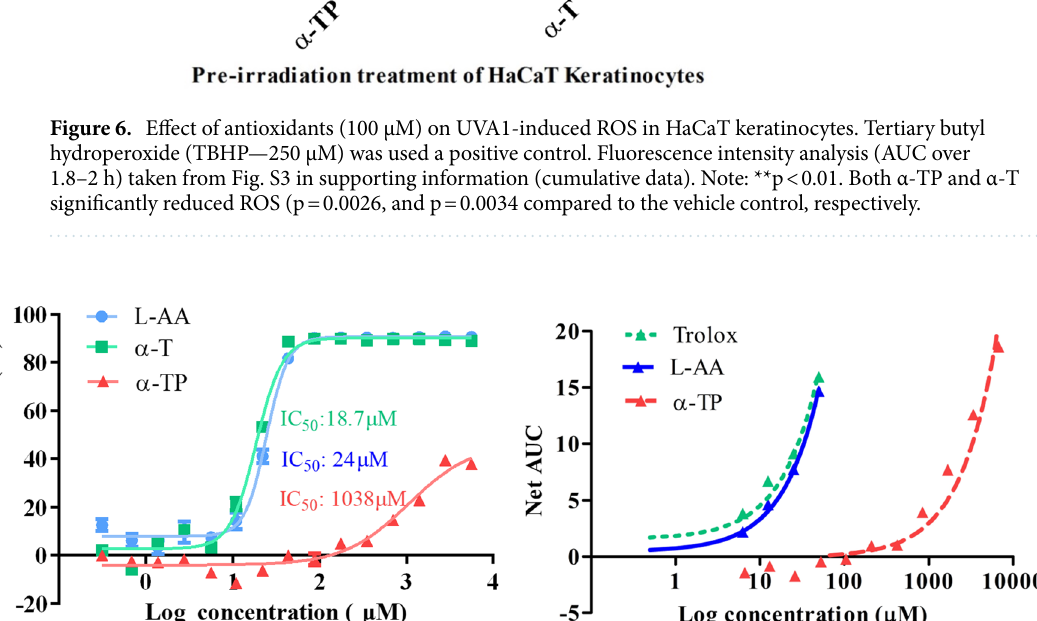
Figure 7. (Left) DPPH radical scavenging ability of α-TP and α-T. l-ascorbic acid (L-AA) was used as a positive control. Aliquots (12.5 μL) of antioxidants at increasing concentrations (0.006–50 mM) were added to